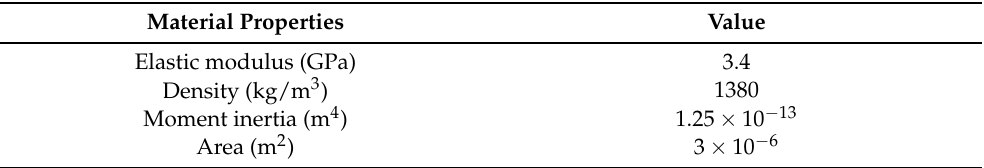
Table 2. Material properties of static simulation.